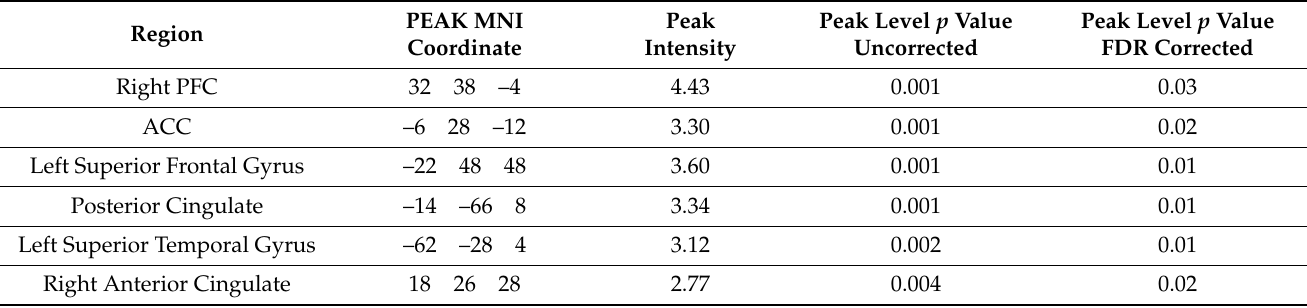
Table 2. Cerebral blood flow differences between the pre- and the post- MBSR program scans during the resting state (PFC = prefrontal cortex, ACC = anterior cingulate cortex). The peak intensity represents the T statistic at the peak statistical significance for the